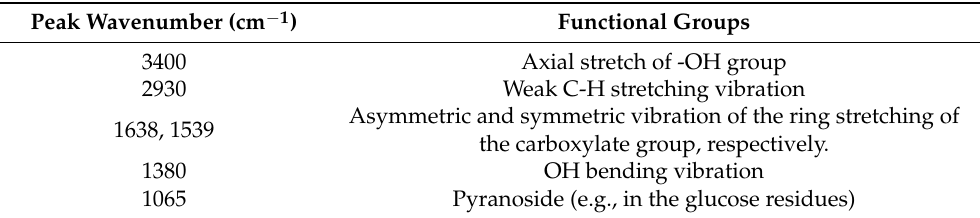
Table 2. FT-IR peaks and bonding characteristics of EPS-LM-1.